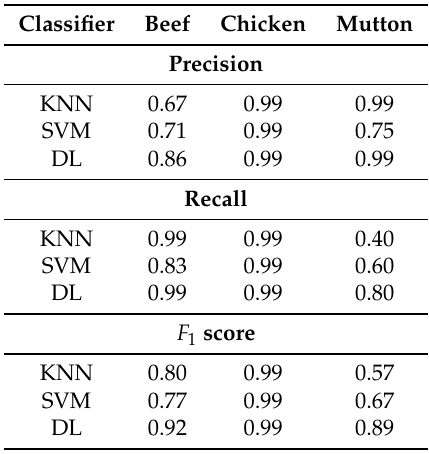
Table 2. Statistical evaluation of SVM, KNN and DL model of Isos-bestic reduction. Classifier Beef Chicken